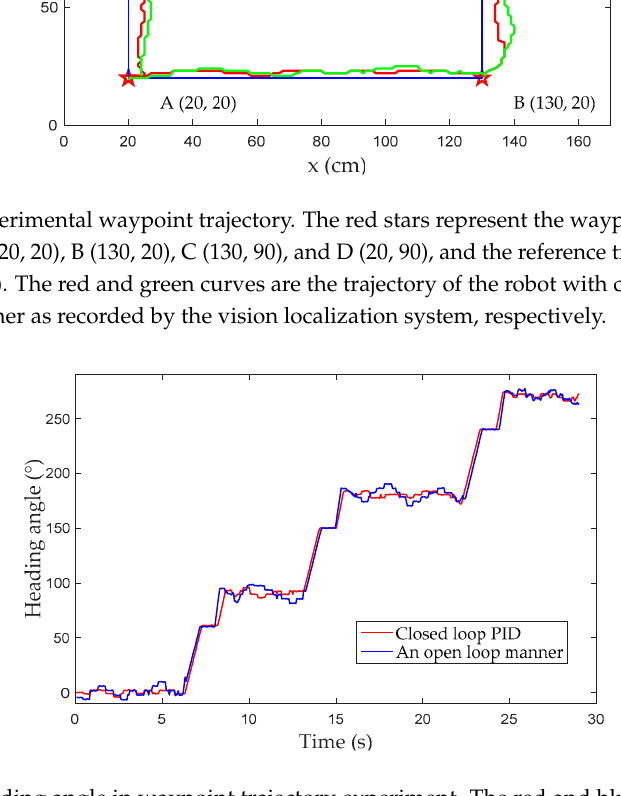
Figure 21. The heading angle in waypoint trajectory experiment. The red and blue curves represent heading angle with closed loop PID and an open loop manner, respectively.